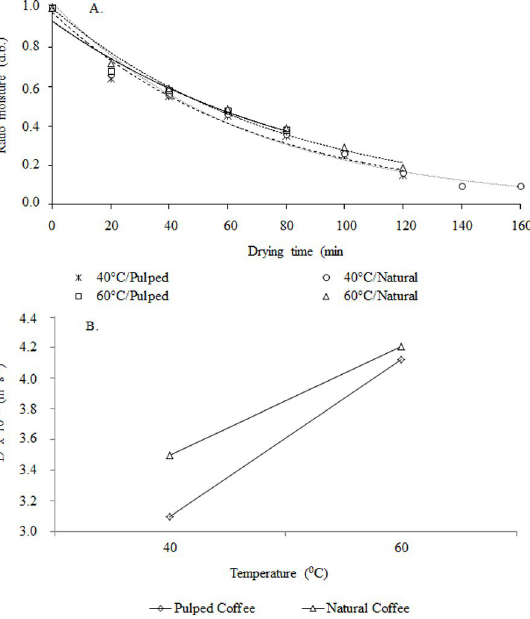
Fig 7. Moisture ratios adjusted by the Midilli model (A), values for the effective diffusion coefficient (B) due to different air temperatures in the drying of natural and pulped coffee.